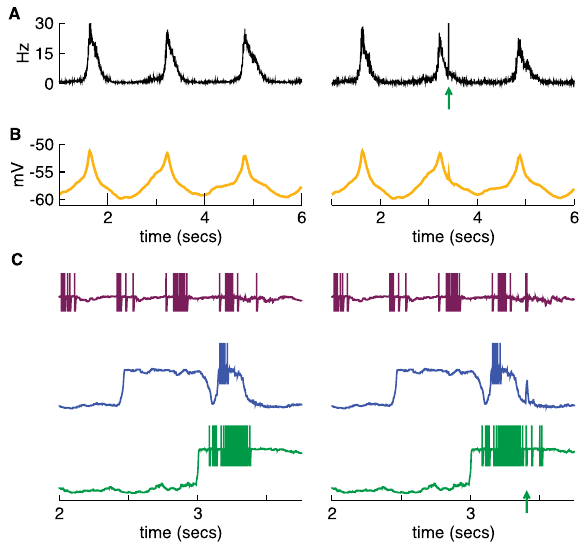
Figure 11. Stimulation during an up state of the regular network . Left : Regularnetworkshowingspontaneousregulartransitionstotheupstate(same network as in Figures 2 and 3 ). Right : Stimulating during an up state of the network at t=3.4seconds. The stimulus has little effect on the network when applied during the up state. At the bottom of this figure we show the effect of the stimulus on the membrane potential traces of three neurons. The arrow indicates the stimulation